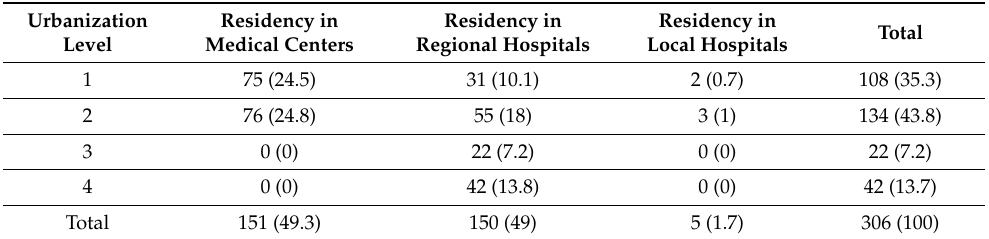
Table 1. The distribution of hospital levels chosen by Taiwanese students who graduated from Polish medical schools (P- IMGs) during 2000–2020, for their residency training, as well as the urbanization level of the area in which they were trained. (%, n = 306). Table 2. The distribution of all residency training positions in Taiwan in 2020 classified by the level of hospitals and the urbanization level of the area in which they are located. (%, n =